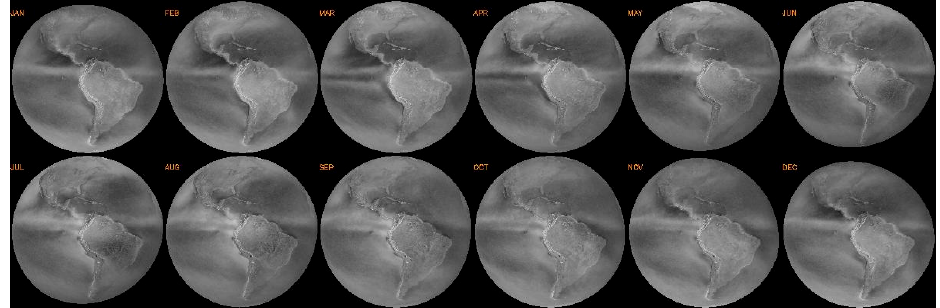
Figure 1. Mean monthly scaled radiance images for GOES-16 (GOES-East) at 17:45 and 17:50 UTC. Range is a linear scale from 0 to 100%. Solar and viewing zenith angles are limited to 80 degrees. Data range is from December 2017 through April 2022.